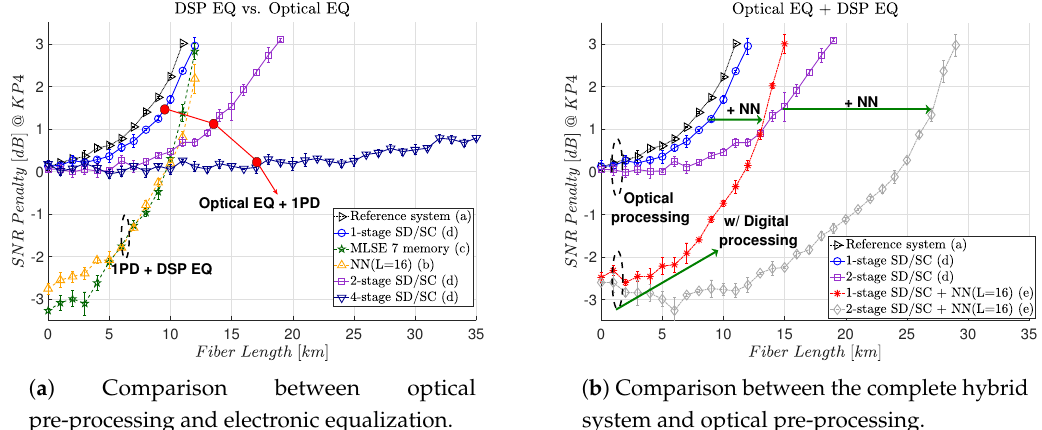
Figure 6. Compared performance of the complete hybrid optoelectronic system. The receiver topology considered in Figure 2 is highlighted inside the parentheses in the legend of the